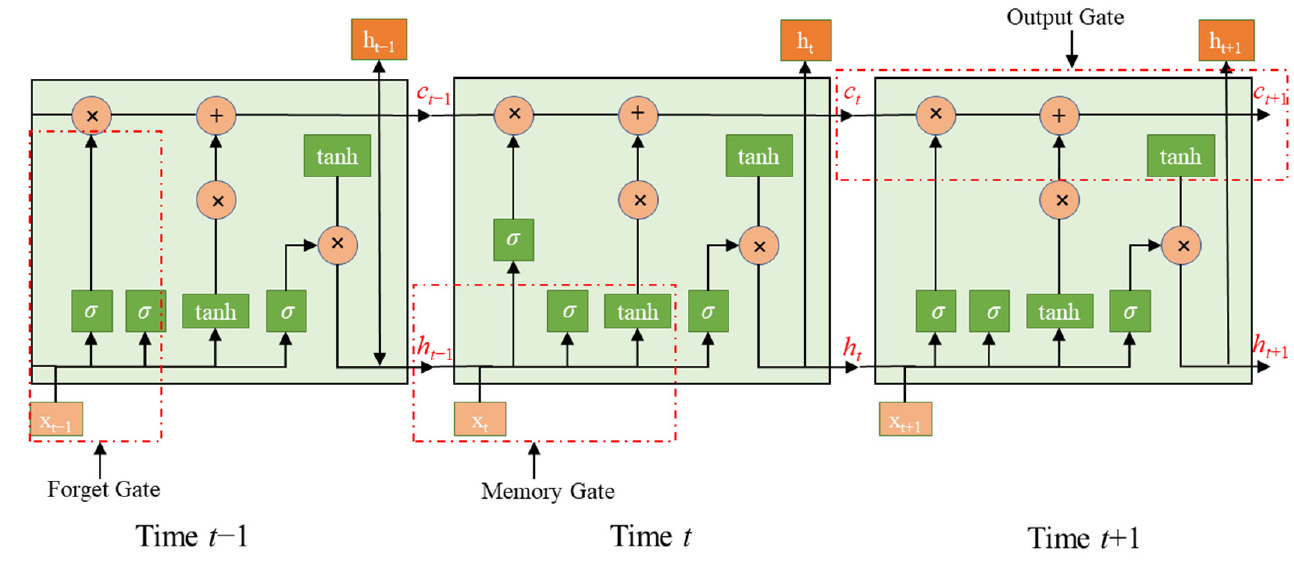
Figure 5. Structure of LSTM gated neurons.